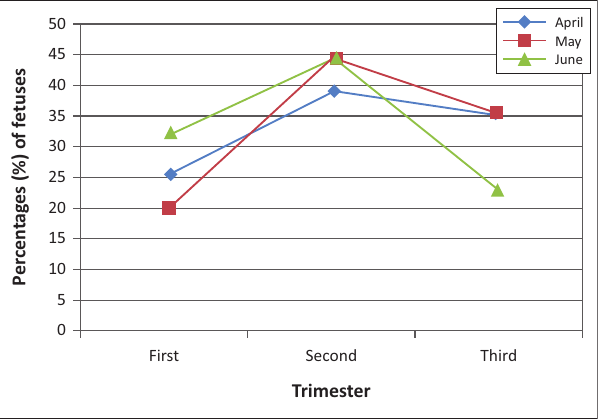
FIGURE 1: Percentage ( % ) of foetuses recovered by trimester and month of the survey period ( n =